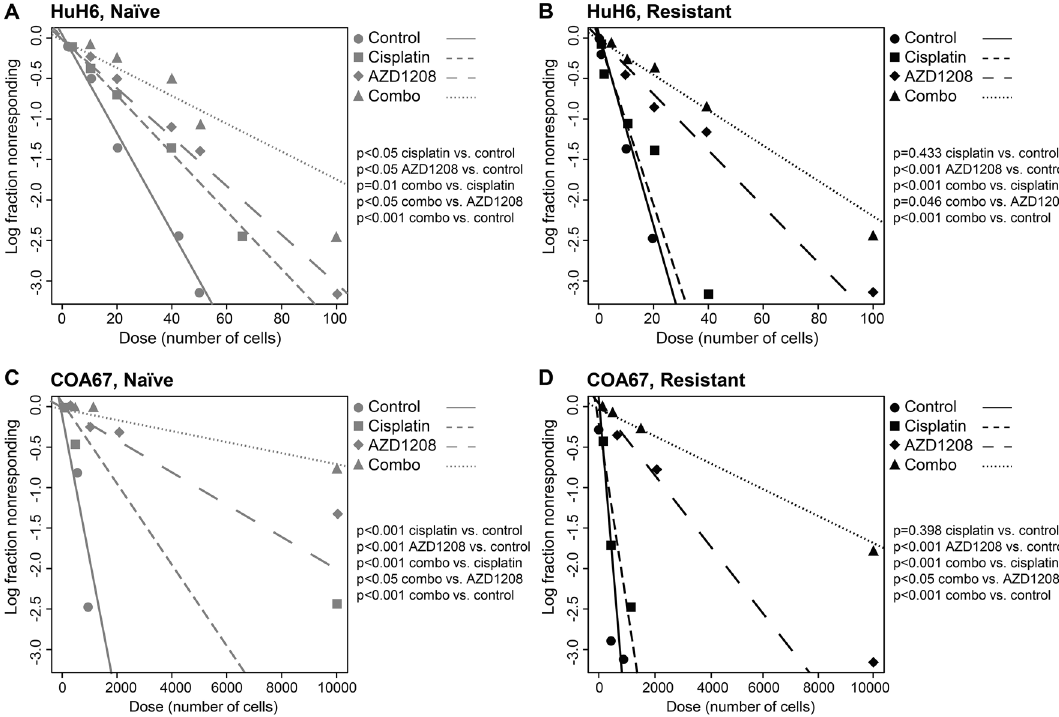
Figure 5. AZD1208 combined with cisplatin reduces the stem cell-like cancer cell (SCLCC) phenotype. HuH6 ( A ) cisplatin-naïve and ( B ) cisplatin-resistant and COA67 ( C ) cisplatin-naïve and ( D ) cisplatin-resistant cells were plated in non-adherent culture conditions at decreasing cell concentrations (from 5000 to 1 cell per well for HuH6 and 10,000 to 1 cell per well for COA67) and treated with 10 µM cisplatin and/or 5 µM AZD1208. After 7 days, wells were examined by a single blinded researcher and the numbers of wells containing spheres were counted. Sphere forming ability was calculated utilizing the extreme limiting dilution software (http://www. bioin f.wehi.edu.au/softw are/elda/) and a plot of the log proportion of negative cultures vs. the number of cells plated is shown. The slope of the line is the estimated log-active SCLCC fraction. In both hepatoblastoma lines, cisplatin treatment did not affect sphere formation in resistant cells (short dashed lines, B , D ), but decreased sphere formation in cisplatin-naïve cells (short dashed lines, A , C , p < 0.05). Treatment with AZD1208 led to decreased sphere formation in both cisplatin-naïve and cisplatin-resistant HuH6 and COA67 cells ( long dashed lines , p < 0.05). Combination of AZD1208 and cisplatin significantly reduced sphere formation in both naïve and resistant HuH6 (dotted lines, A , B ) and COA67 (dotted lines, C , D ) cells compared to cisplatin or AZD1208 alone, or to untreated controls (p <